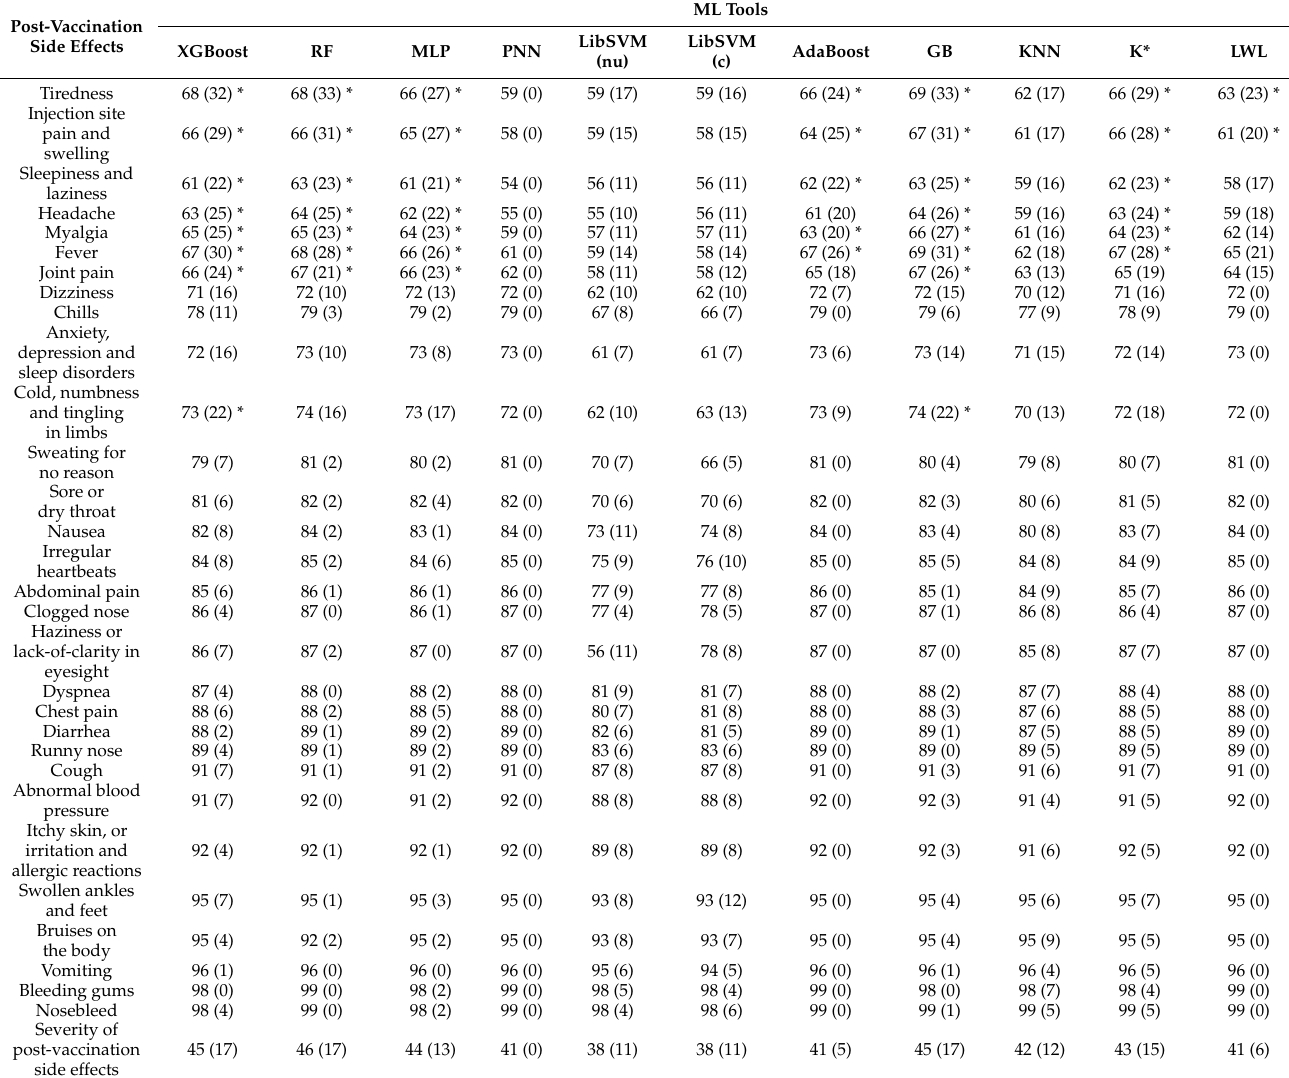
Table 6. Accuracy and Cohen’s κ values for predicting the frequency and severity of post-vaccination side effects, based on 15 predisposing factors, using 11 ML